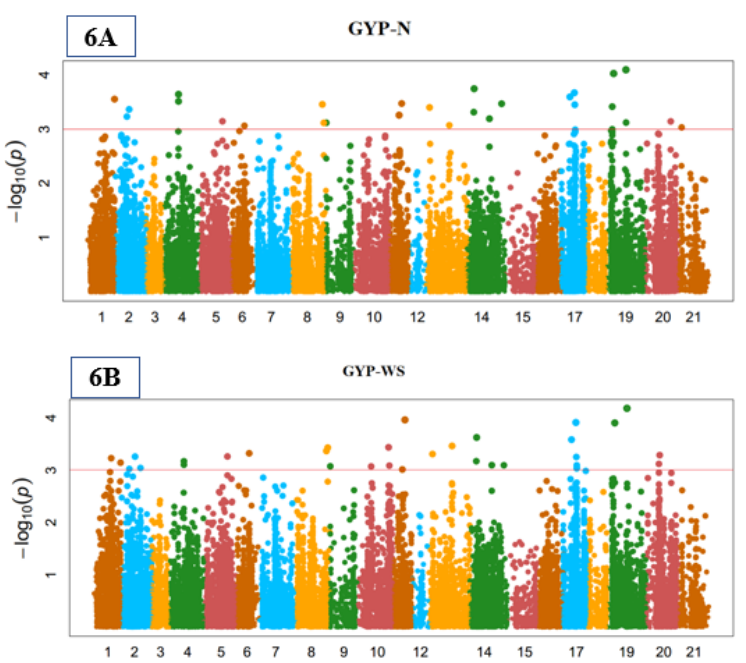
Figure 5. Manhattan plot of number of grain per spike (NGS) under normal (N) ( A ) and water short- age (WS) ( B ) conditions. Manha tt an plots showing the location of signi fi cant SNPs and − log10( p ) associated with number of grain per spike in bread wheat under normal and water shortage condi- tions. The red horizontal line on Manhattan plot entitles the threshold level ( p < 0.0001) of signifi- cance for SNPs with this trait.